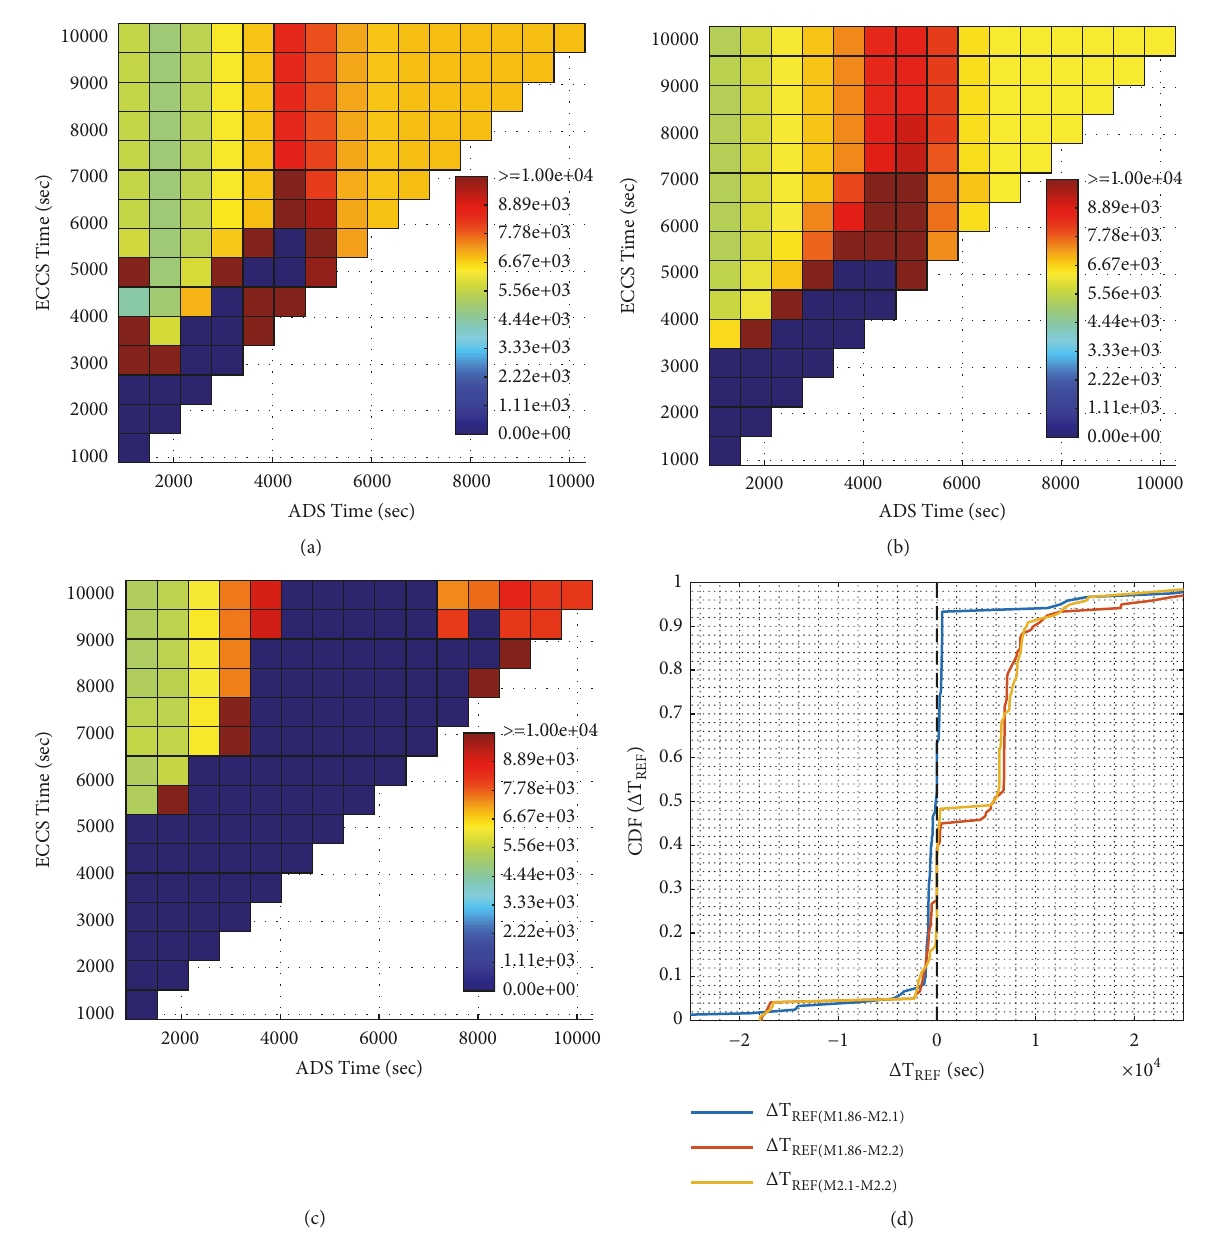
Figure 7: Time of core support plate failure as a function of ADS time and ECCS time obtained with (a) MELCOR 1.86, (b) MELCOR 2.1, and (c) MELCOR 2.2. (d) Cumulative distributions of the differences in 𝑇 𝑡𝑒𝑓 between different MELCOR code versions.